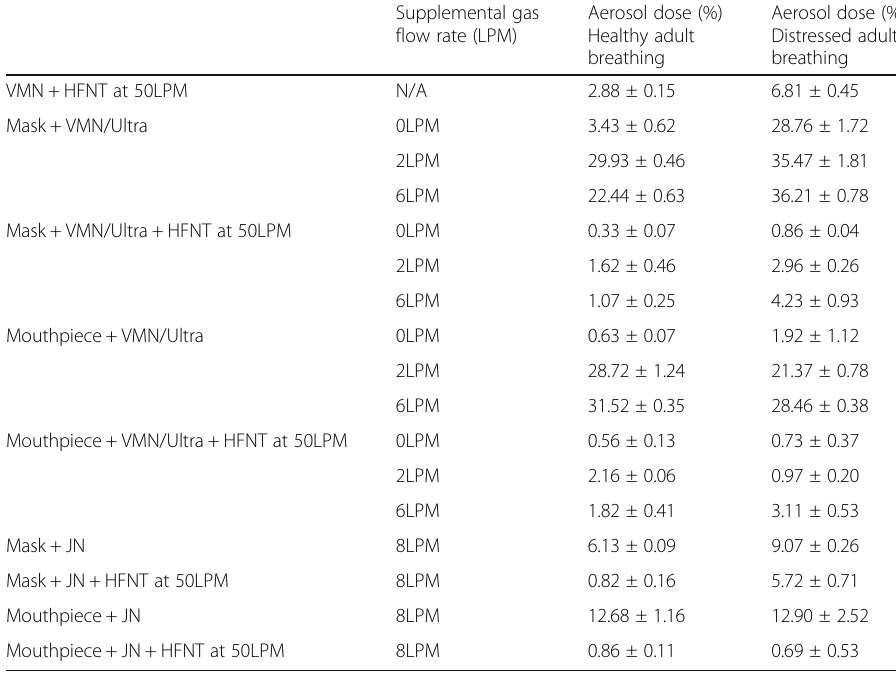
Table 1 Results of aerosol dose across different drug delivery interfaces during simulated healthy adult and distressed breathing. LPM liters per minute, N/A not applicable. VMN does not require supplemental gas flow for normal operation. The values represented are mean ± standard deviation (expressed in percentage) of three independent experiments Supplemental gas flow rate (LPM)